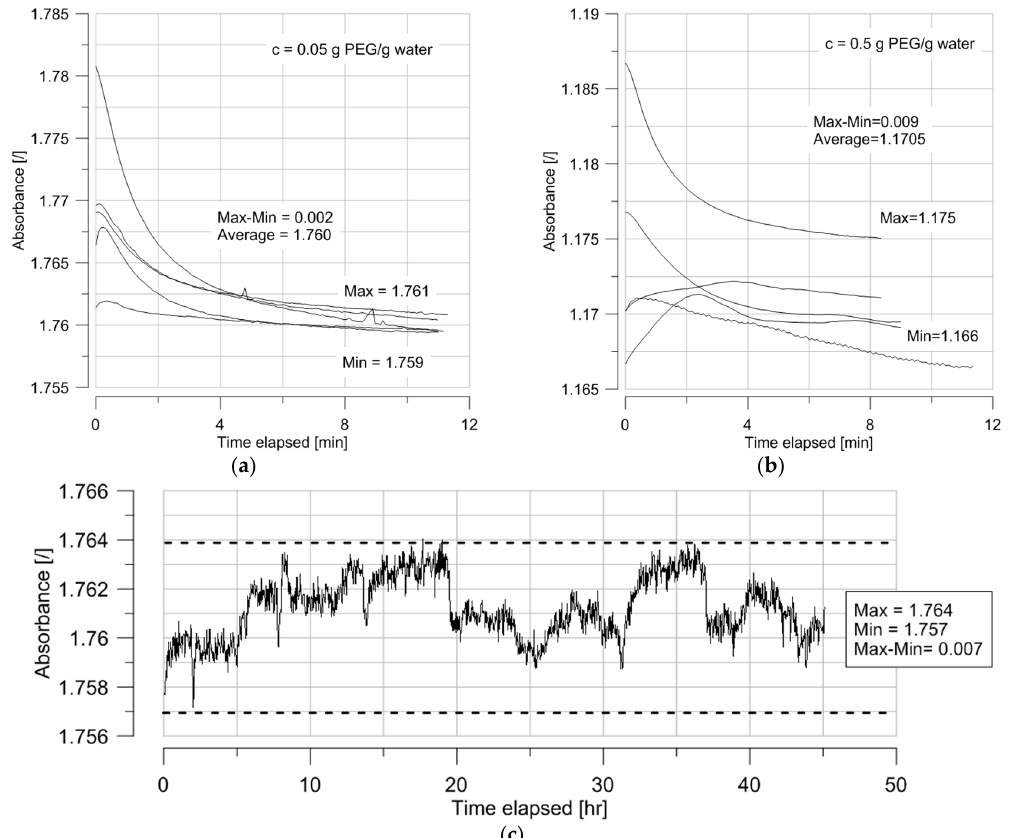
Figure 5. ( a ) Repeated absorbance measurements for PEG 20,000 at 0.05 g PEG/g water; ( b ) Repeated absorbance measurements for PEG 20,000 at 0.5 g PEG/g water; ( c ) Continuous measurement of PEG 20,000 at 0.05 g PEG/g water over a 45-h period. All tests were performed at 20.5 degrees Celsius.